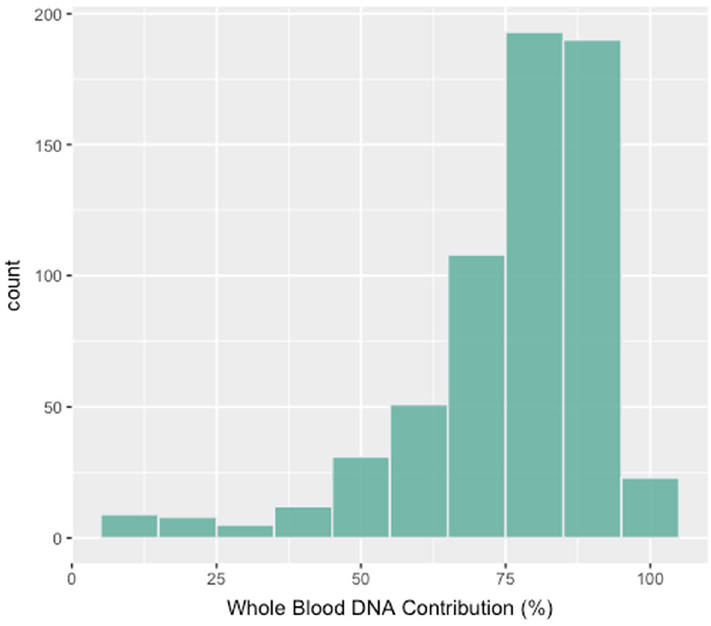
Figure 7. The WB contribution to the total human DNA component of saliva DNA as determined using the DMR11 assay (n = 601).